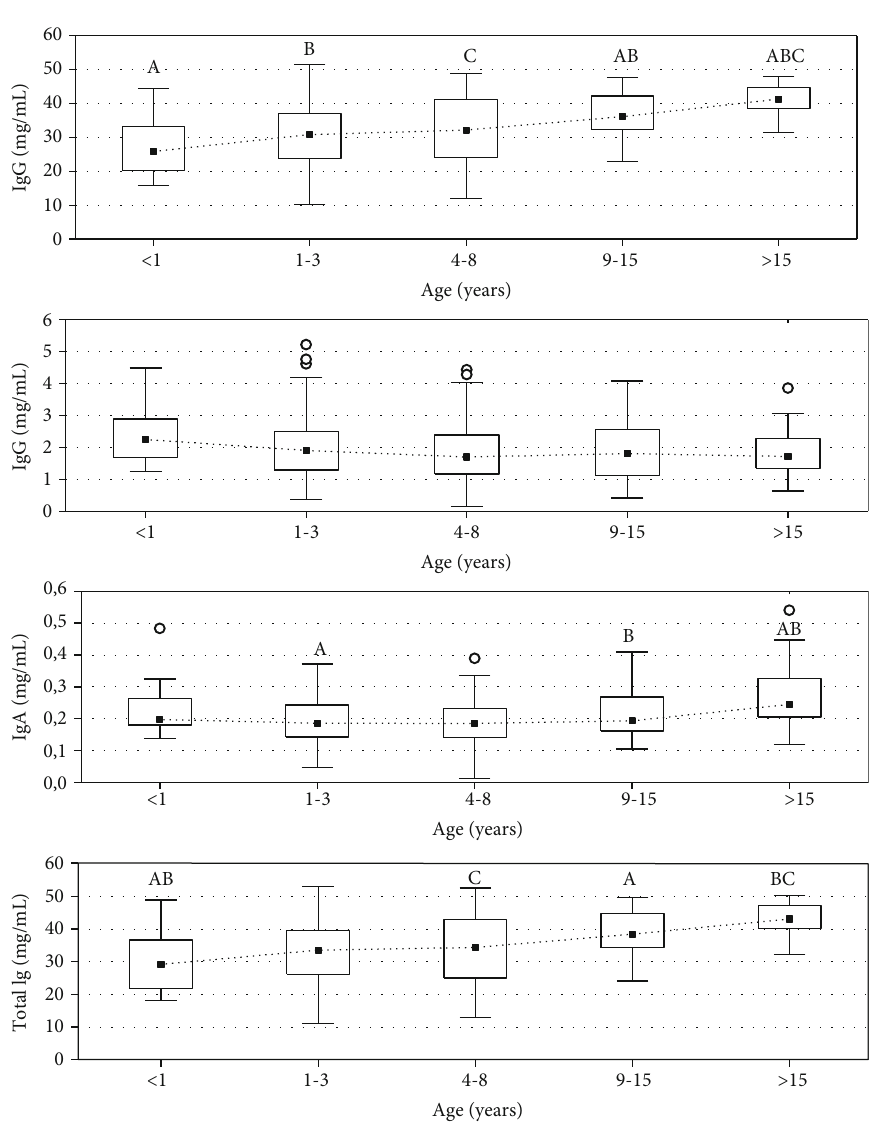
Figure 1: Distribution of the absolute concentration (mg/mL) of IgG, IgM, and IgA and total concentration of analyzed Ig (total Ig) in serum of apparently healthy European bison of various ages. Dotted line represents median values, boxes represent the 25th and 75th percentiles, and error bars indicate the 5th and 95th percentiles for each immunoglobulin class. The circles represent outliers. abc Values with the same superscript di ff er signi fi cantly between age groups within the same class of immunoglobulin ( p < 0 : 05